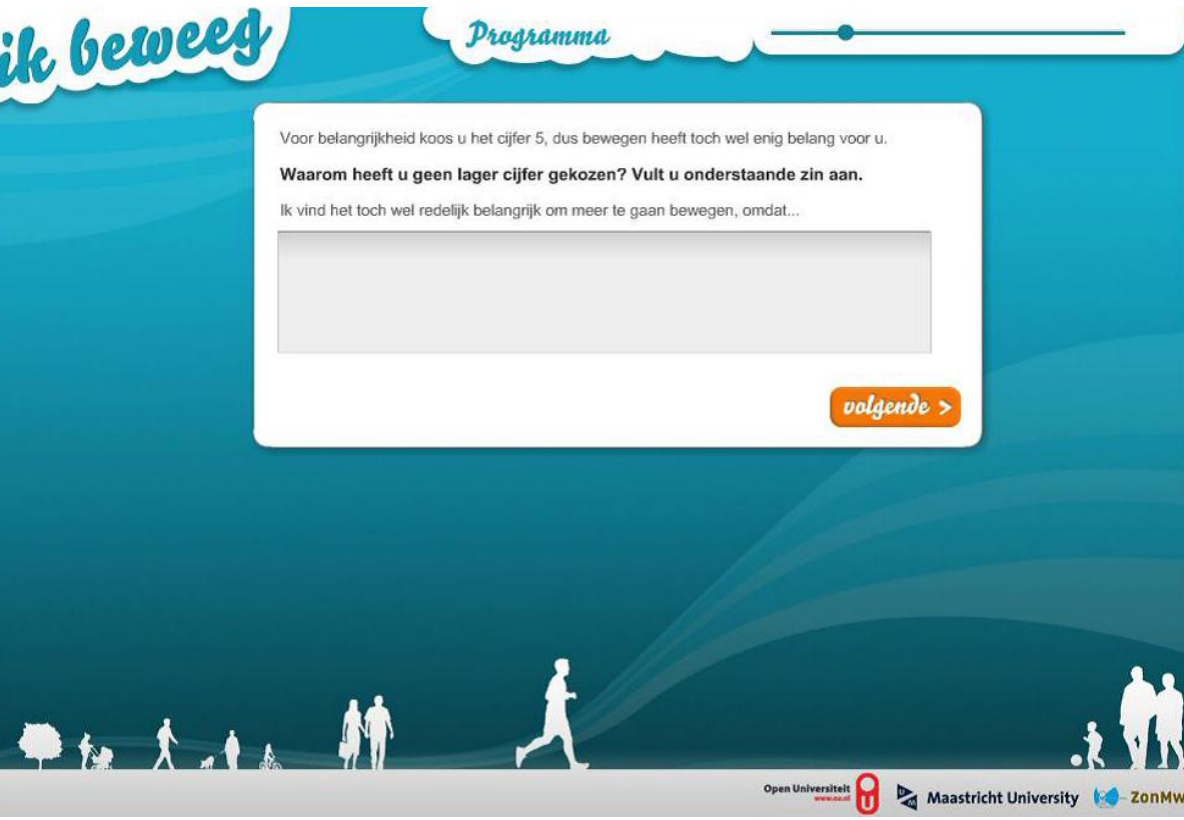
Figure 1. Screenshot of the TEXT